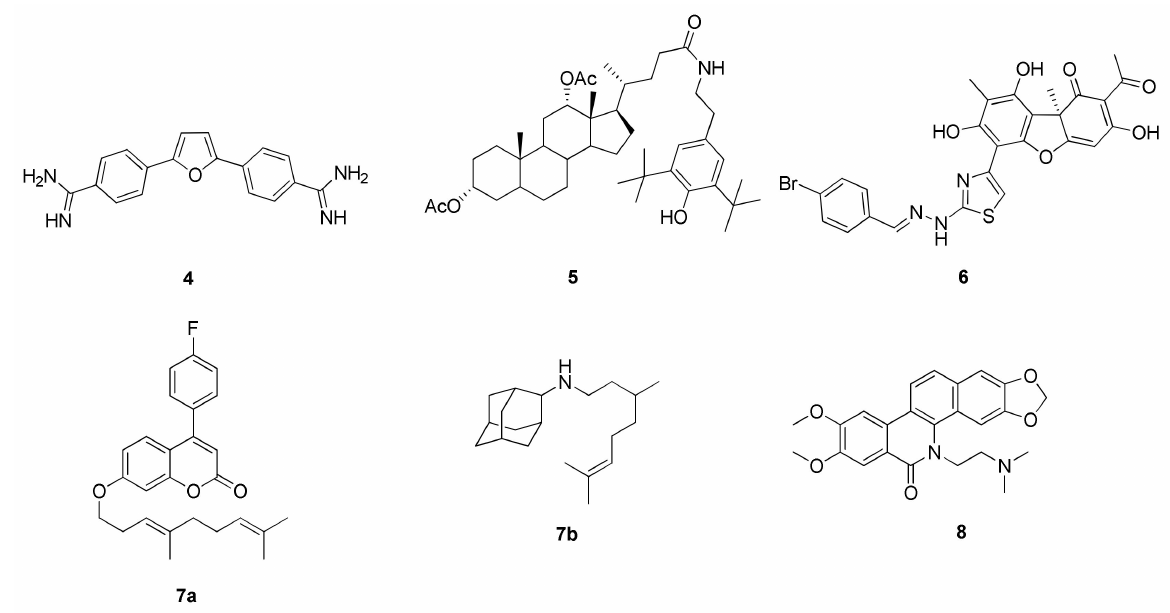
Figure 2. A few classes of known Tdp1